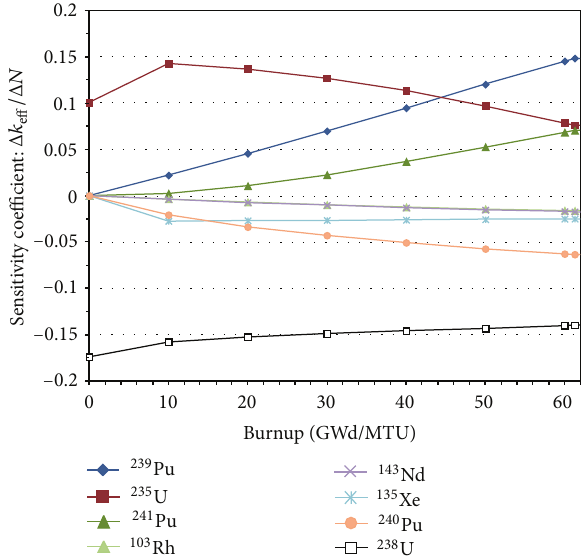
F 4: Sensitivity coefficients calculated with SCALE6.1/TRI- TON/TSUNAMI.